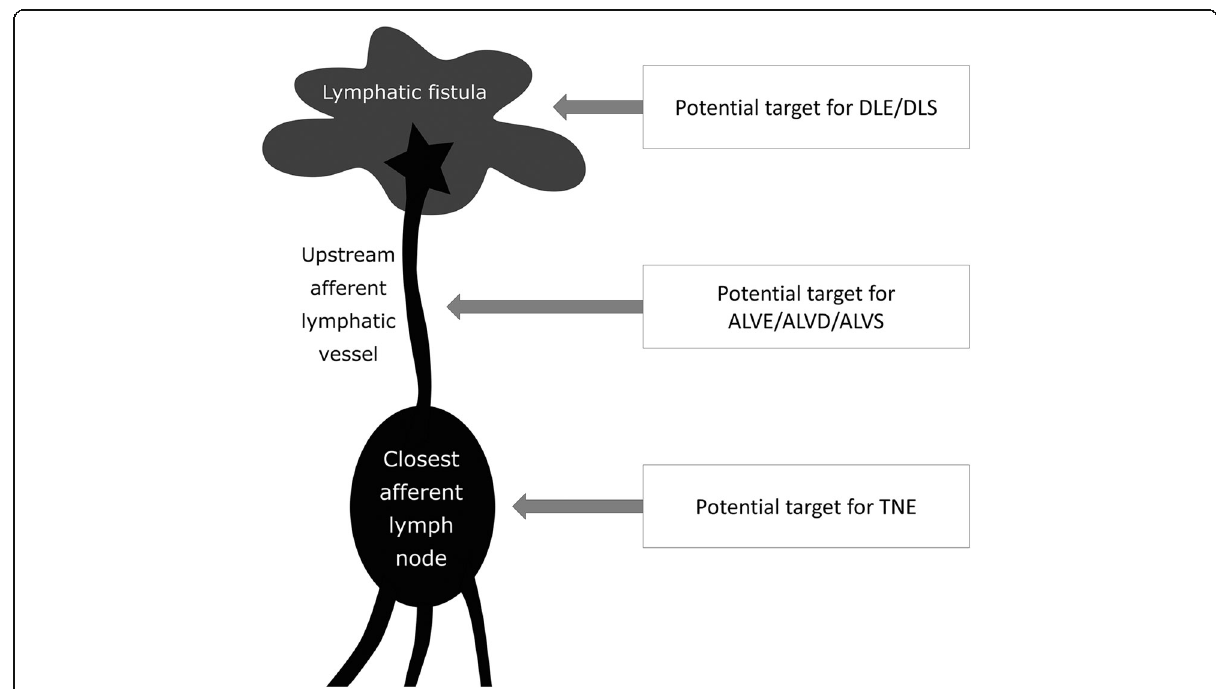
Fig. 4 Illustration of the potential targets for different interventions